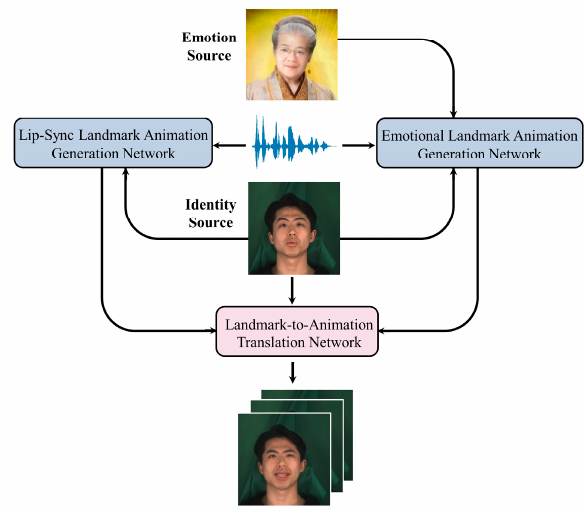
Figure 1. The abbreviated framework of the proposed method. Two portraits and audio are input, and a video of the identity source portrait talking face with new emotional expressions is obtained as output.